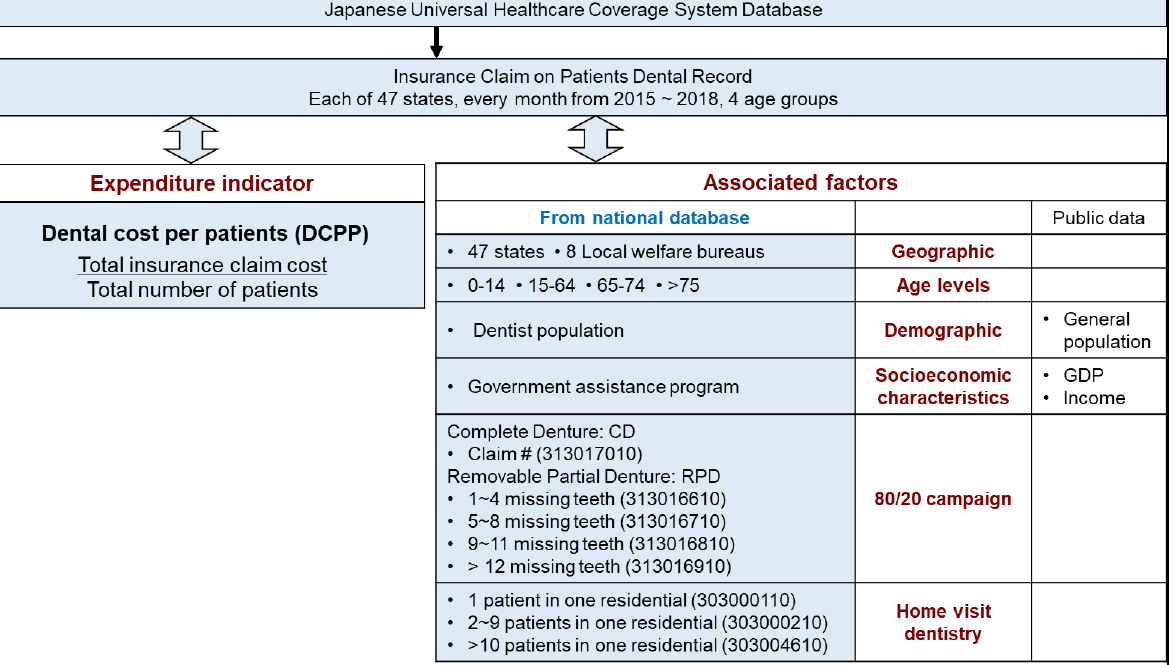
Figure 1. Scheme of the study design. Study data were extracted from the Japanese Universal Healthcare System (UHCS) database. Monthly Dental Cost Per Patient (DCPP) was calculated and the association between DCPP and associated factors of six categories were